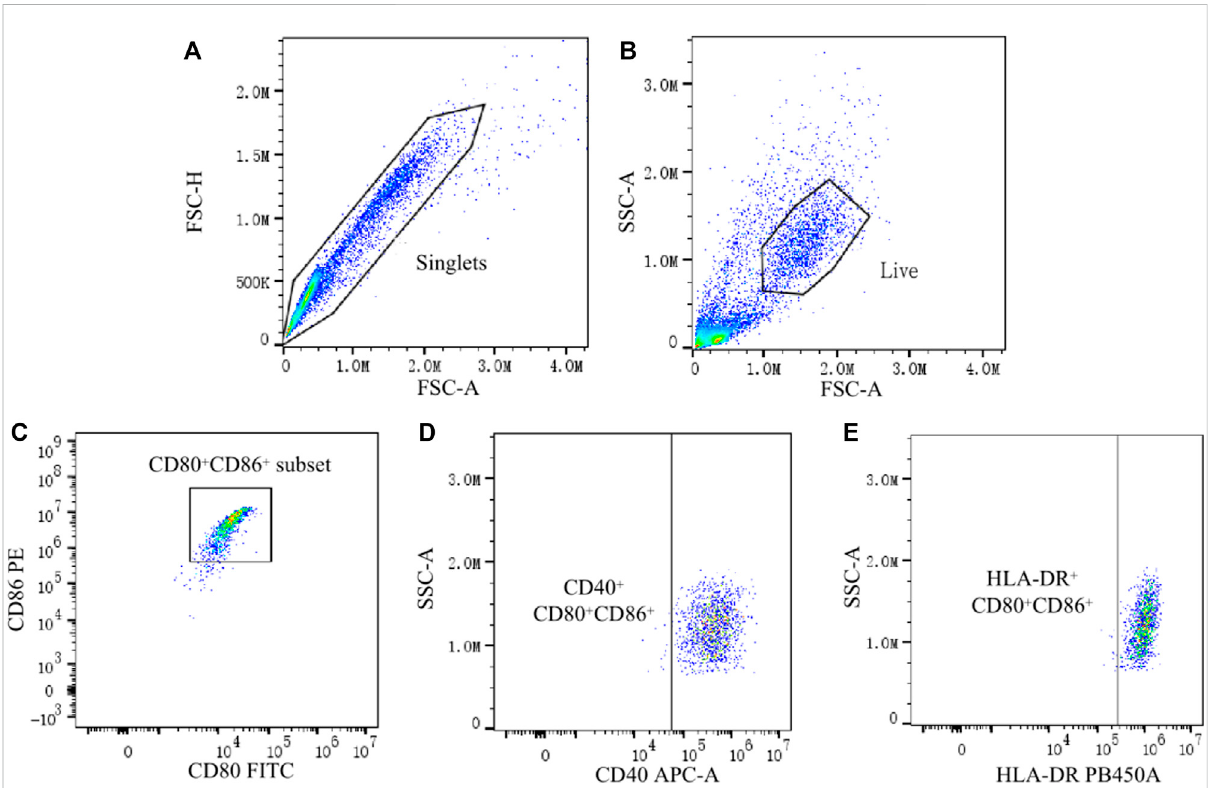
FIGURE 1 Analysis of CD40 and HLA-DR expression on moDCs by fl ow cytometry. (A) Single cells were gated by the Forward Scatter area (FSC-A) and Forward Scatter height (FSC-H). (B) Live cells from the single cells were further gated by the FSC-A and Side Scatter area (SSC-A). (C) CD80 + CD86 + cells (moDCs) were gated from live cells. (D,E) Finally, the expression of CD40 and HLA-DR on CD80 + CD86 + cells were